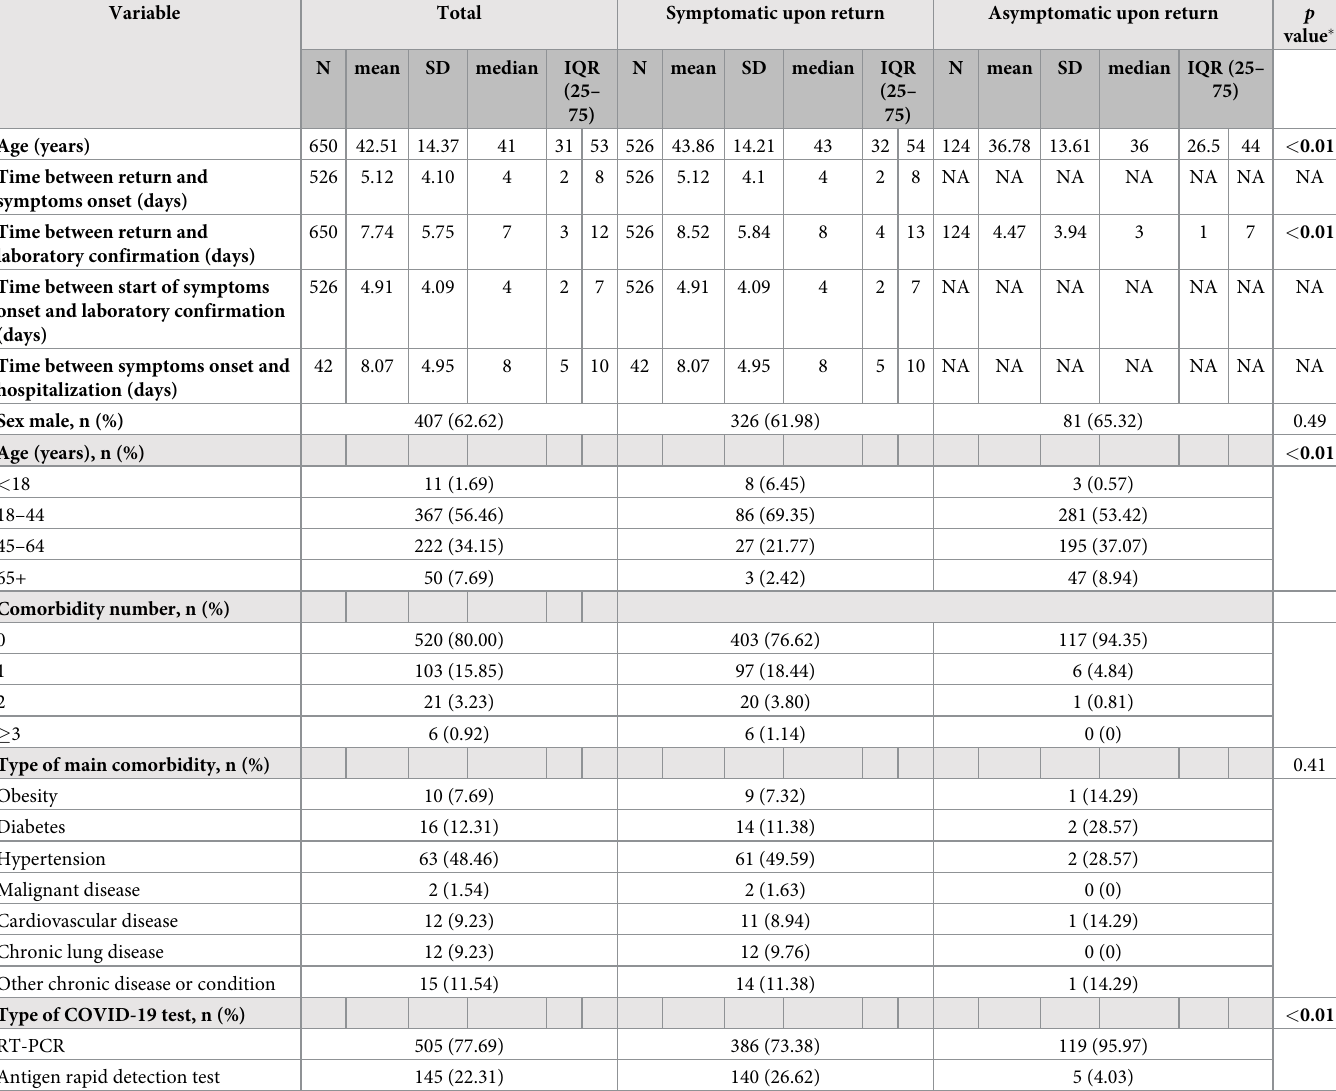
Table 1. Sociodemographic, epidemiological and clinical characteristics of COVID-19 travel-associated cases, total and by clinical presentation upon return, in Voj- vodina, Serbia, in the period March 6—December 31, 2020.